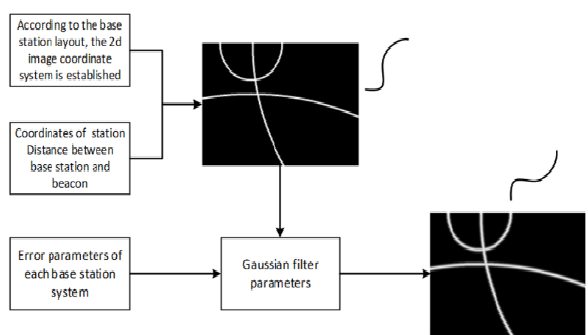
Figure 2 . Signal space score map generation flow chart.